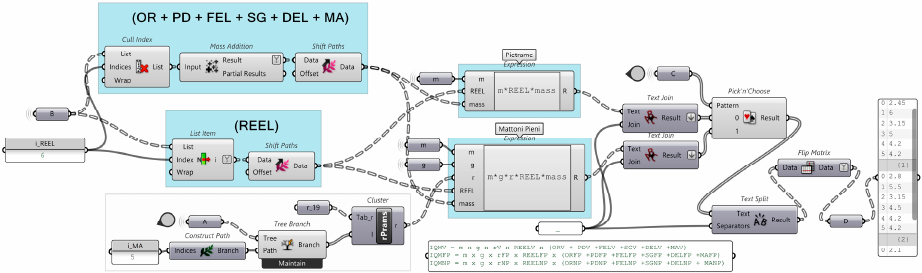
Figure 9. Portion of code dedicated to the calculation of the IQM expressed for the three solicitations for the selected walls.